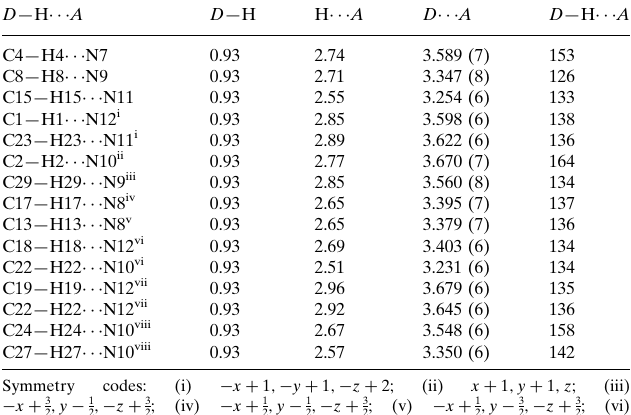
Hydrogen-bond geometry (A˚ , (cid:3)